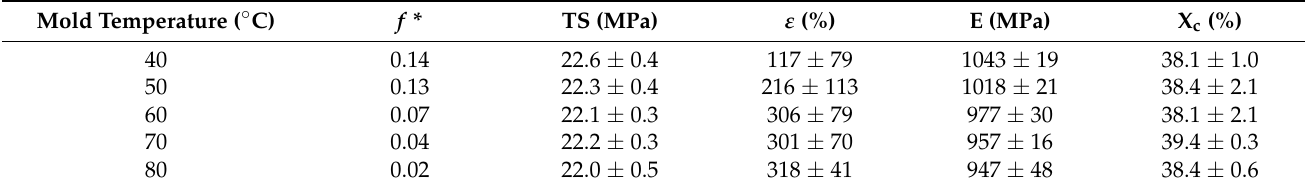
Table 11. Overview on the influence of mold temperature on the orientation function f , tensile properties (TS, ε and E), and crystallinity content (X c